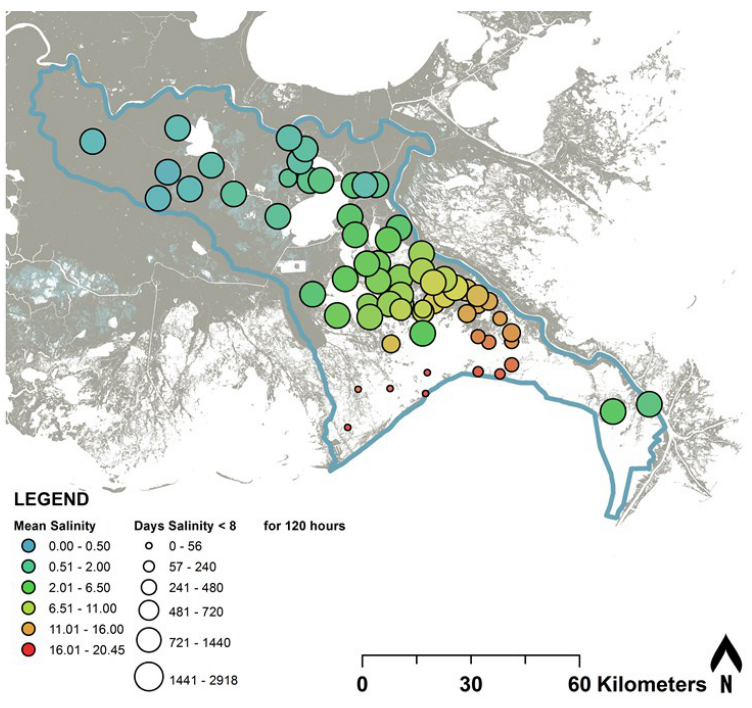
Figure 6. Average salinity by color gradient with the size of the points representing the number of events since 2008 where the salinity was less than 8 ng/kg for at least 120 consecutive hours.